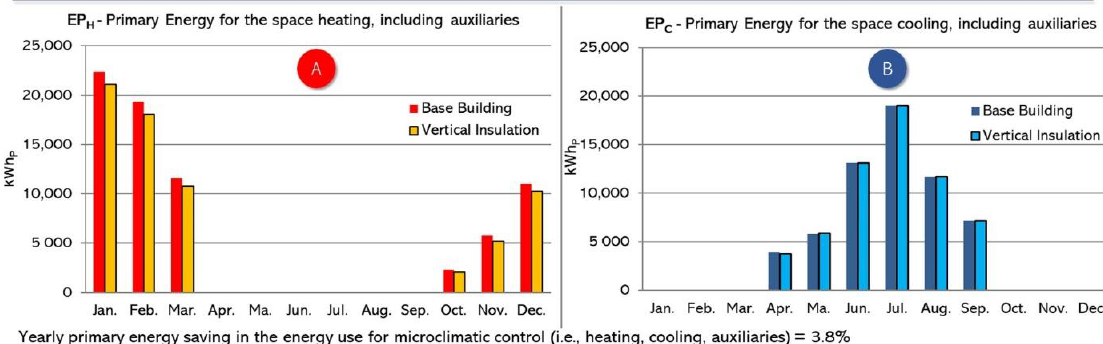
Figure 11. HVAC heating and cooling primary energy demand, before and after the thermal insulation addition.